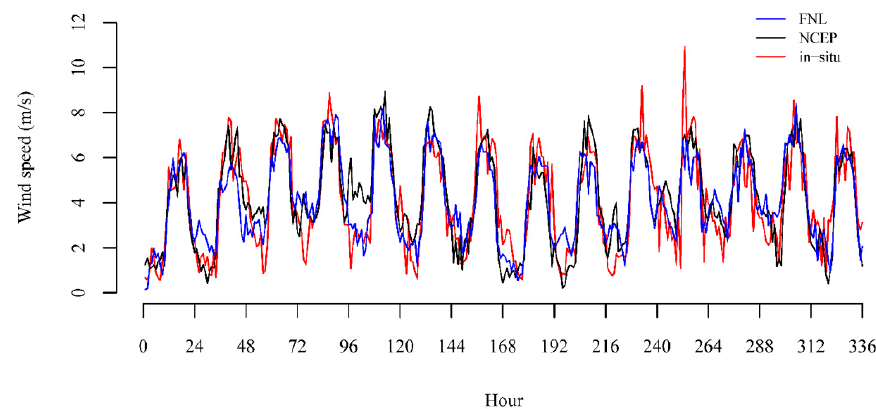
Figure 6. 10 m level wind speed time series at Piarco for 1–14 April 2003 from in-situ data (red line) compared with WRF model simulations initialized with FNL data (blue line) and those with NCEP-DOE reanalysis data (black line).